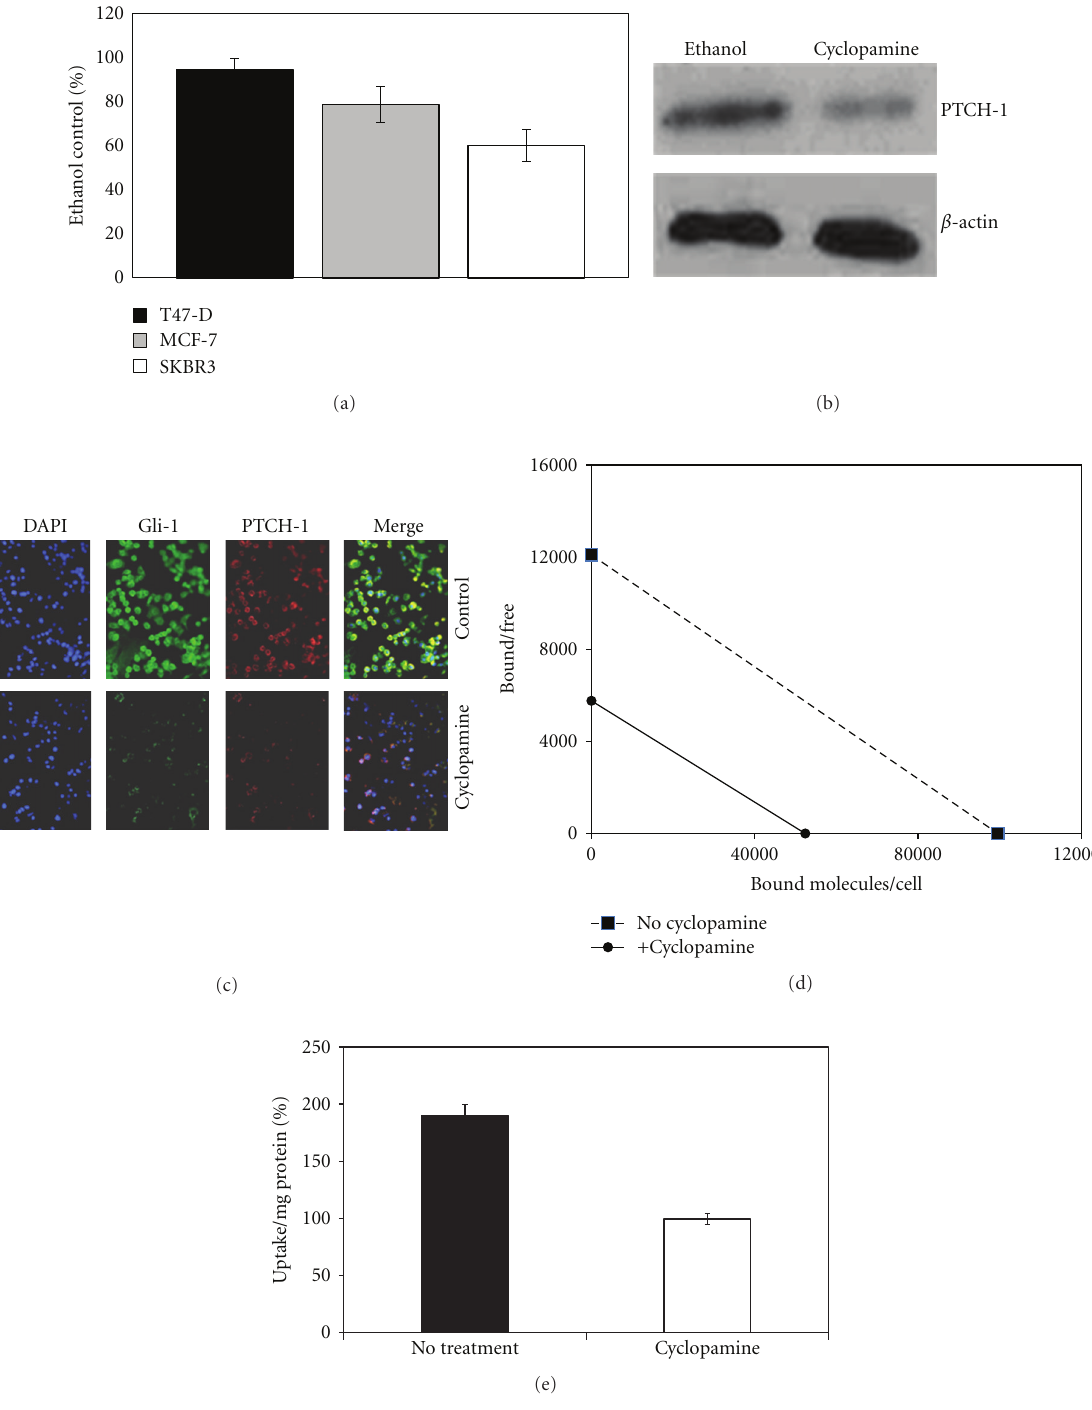
Figure 3: (a) MTT assay showing decrease in proliferating cells after treatment with 20 μ M cyclopamine for 48 hours. Data is expressed as % of control (ethanol treatment only). (b) Western blot showing decrease in PTCH-1 expression in SKBR3 cells treated with 20 μ M cyclopamine as compared to cells treated with ethanol only. (c) Immunofluorescence showing decrease in PTCH-1 and Gli-1 (nuclear and cytoplasmic) 24 hours after treatment with cyclopamine. (d) Scatchard analysis of 131 I-SHH binding to the surface of SKBR3 cell lines with and without treatment with 10 μ M cyclopamine. There is a 5-fold decrease in surface PTCH-1 receptor expression 48 hours after treatment. (e) Reduced cellular uptake of 131 I-SHH in the PTCH-1 receptor positive breast cancer cell line SKBR3 with and without treatment with the HH inhibitor